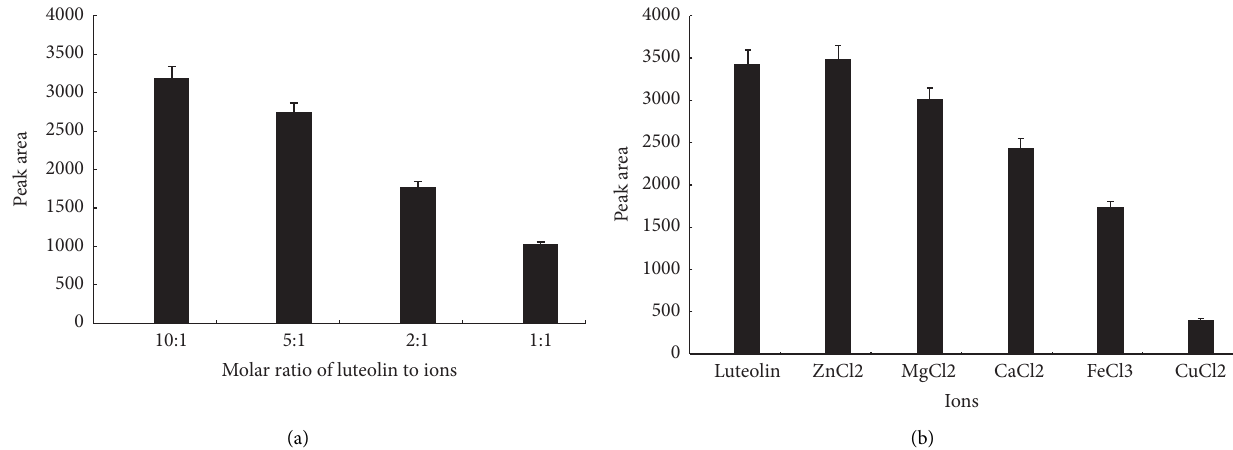
Figure 4: (a) Effect of the molar ratio of luteolin to metal ions on the formation of luteolin-metal complex ( n � 3). (b) Effect of different types of metal ions on luteolin-metal complex formation ( n � 3). Table 1: Effect of luteolin, metal salt and luteolin, and metal ion reaction products on clearance of DPPH free radicals. Concentration,